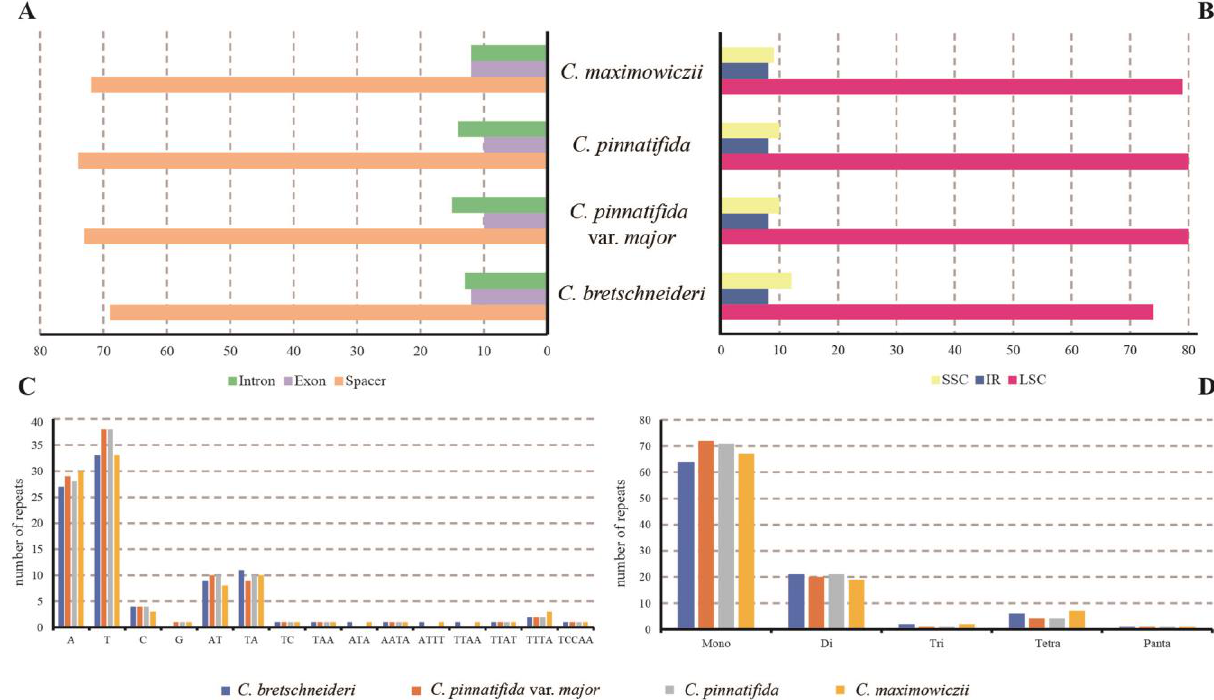
Figure 7. Types and distribution of simple sequence repeats (SSRs) among the four Crataegus plastomes. ( A ) SSR distribution in various regions. ( B ) Frequency of SSRs in the LSC, IR, and SSCregions. ( C ) Number of detected SSR motifs in different classes of repeats. ( D ) Frequency of each SSR type.